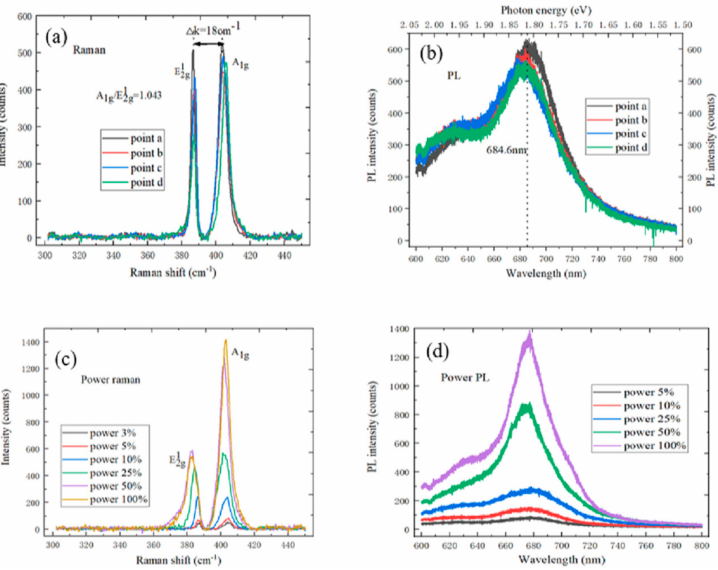
Figure 2. ( a ) The Raman spectrum of monolayer MoS 2 at the di ff erent test points; ( b ) the PL spectrum of monolayer MoS 2 at the di ff erent test points; ( c ) the Power Raman spectrum of monolayer MoS 2 ; and ( d ) the Power PL spectrum of monolayer MoS 2